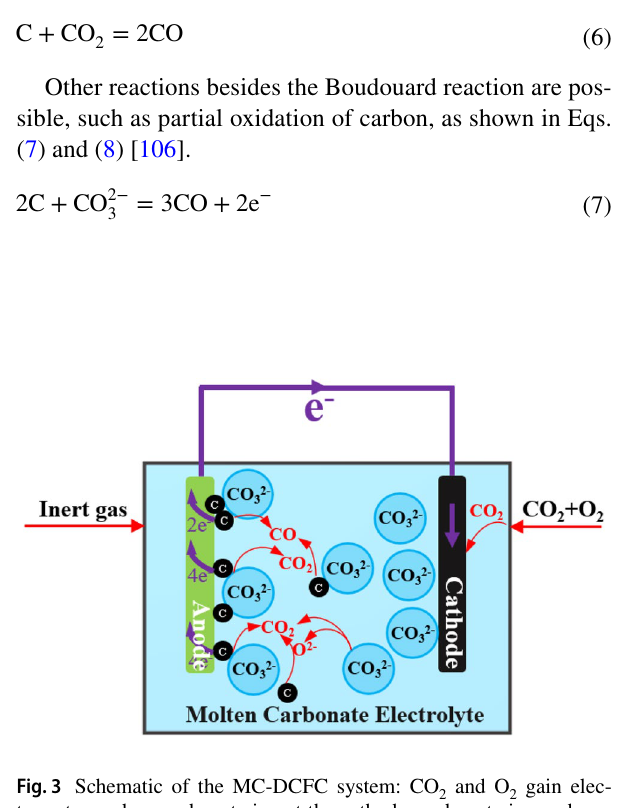
Fig. 3 Schematic of the MC-DCFC system: CO 2 and O 2 gain elec- trons to produce carbonate ion at the cathode; carbonate ion and car- bon generate CO or CO 2 and electrons at the anode. At the same time, carbonate ion is likely to decompose into O 2− and CO